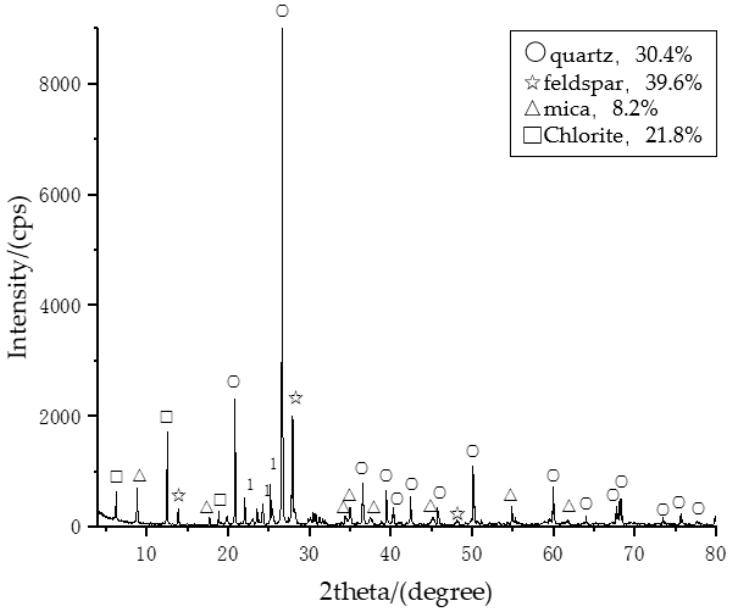
Figure 6. X ‐ ray diffraction analysis results of rock samples.